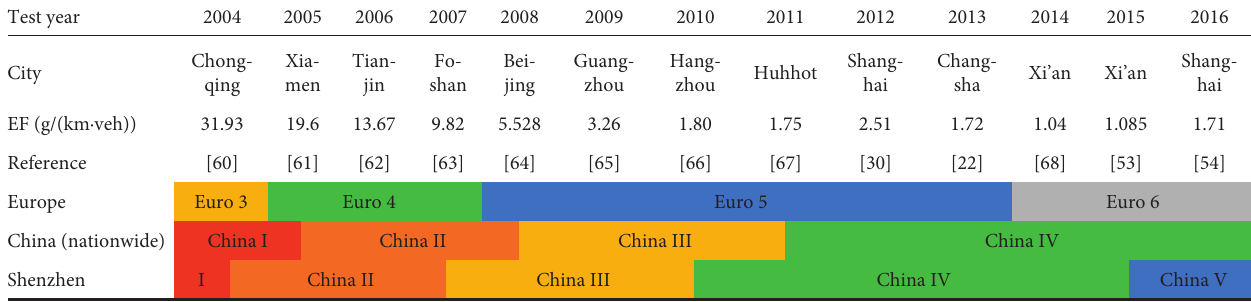
Table 9: CO emission factors of passenger cars in different cities in